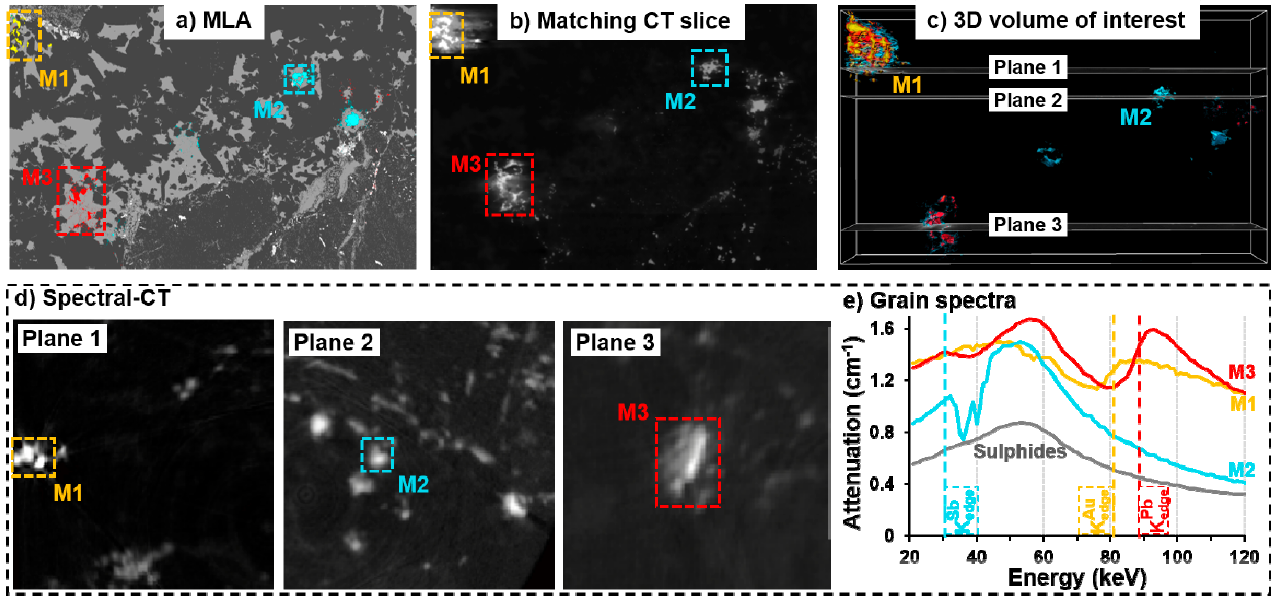
Figure 4. Three grains (M1-M3) classified by ( a ) MLA with the same grains represented in the ( b ) CT image (2D plane matching the MLA image) and ( c ) 3D view of the volume of interest. ( d ) The same grains imaged using Sp-CT on planes 1–3 that are perpendicular to the MLA image as marked in ( c ). ( e ) The measured spectra of grains M1-M3 and the sulphides matrix. Grain M1 (yellow) is identified by MLA and sp-CT as gold. Grain M2 (blue) is identified as tetrahedrite by MLA and the K-edge of Sb is identified. Grain M3 (red) is identified by MLA as boulangerite and the K-edge of both Sb and Pb are identified.